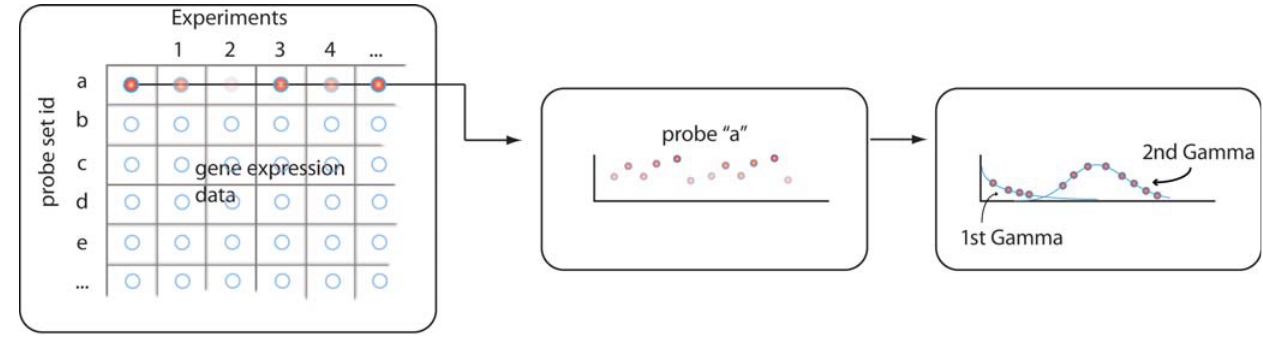
Figure 1. Data handling in the mixture algorithm. First, gene expression data from a set of gene expression experiments is collected. The matrix in the figure shows rows probe set, where every row is a single probe set, and every column is a different hybridization experiment. This could be, for example, Affymetrix microarray experiments, where each column is a different patient. We then look at the data probe-by-probe. For example, we follow probe ‘‘a’’ in the figure and look at the expression levels for this probe, across all samples in the set of gene expression experiments. Each probe will have data from the entire collection of experiments. For the specific probe ‘‘a’’, we fit the set of expression measurements into two gamma distributions, one representing the ‘‘down’’ state and one representing the ‘‘up’’ state. Each data point is then computationally associated with a probability of being either under the first Gamma distribution (which would mean the gene associated with the probe, for the specific sample, is at a ‘‘down’’ state) or with the second Gamma distribution (which would mean the gene associated with the probe, for the specific sample, is at an ‘‘up’’ state). We iterate the procedure across the entire probe-set, to tag every gene across the microarray with its probability of being ‘‘up’’ or ‘‘down’’.